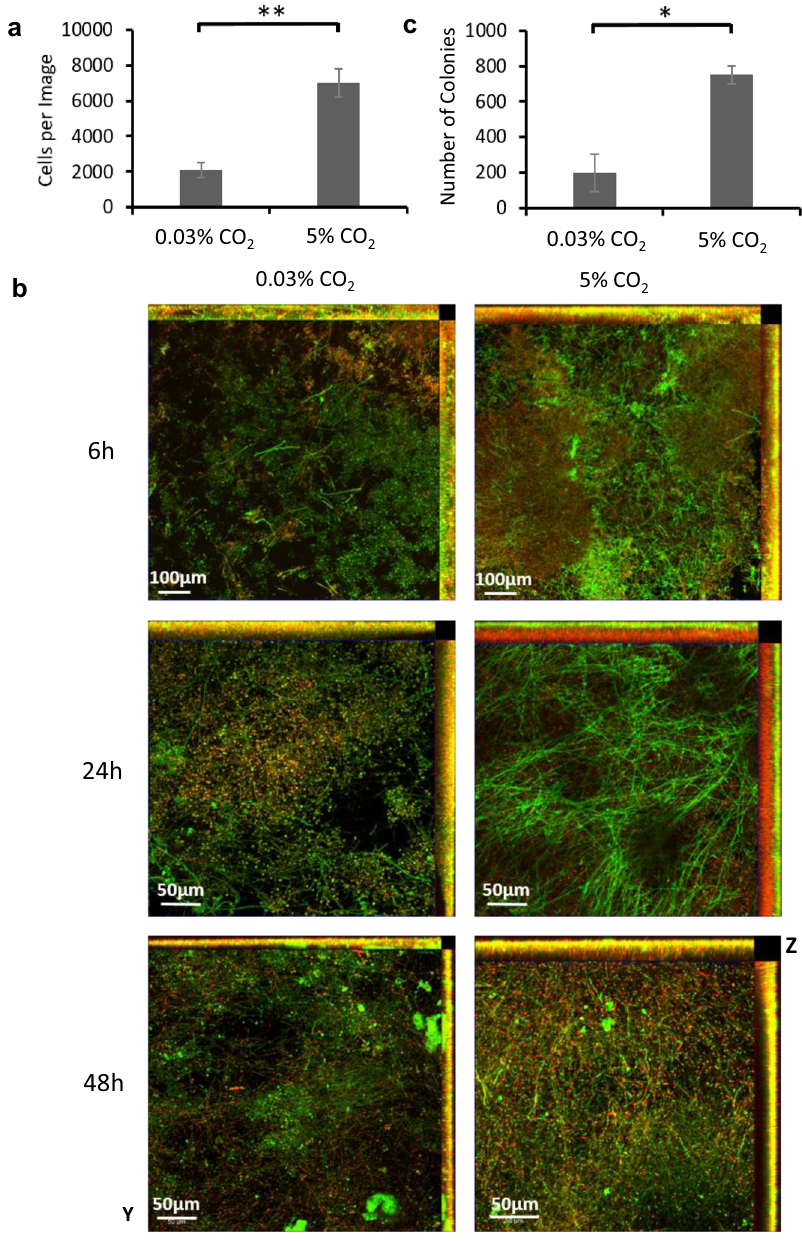
Fig. 2 The effects of CO 2 on C. albicans bio fi lm growth. a Attachment: C. albicans CAI-4 cells were seeded onto silicone-coated microscope slides under 0.03% or 5% CO 2 and images were taken at ×20 objective magni fi cation. Cells per image were counted and the mean was calculated across three biological replicates ( fi ve images per replicate). A paired two-tail t test was carried out: ** p < 0.01. Error bars denote standard deviation. b Maturation: Bio fi lms were seeded on silicone-coated microscope slide and grown for 6, 24 and 48 h. Bio fi lms were stained with ConA-FITC (green) and FUN-1 (red). Z -stack images were taken using ×20 (6 h) and ×40 (24 and 48 h) magni fi cations. Experiments were repeated in triplicate and representative maximum intensity images are presented as well as Z -stack pro fi les. c Dispersion: Spent media was collected from bio fi lms grown for 48 h in 0.03% or 5% CO 2 and diluted 1:10 before being plated to assess the number of colonies. Three biological replicates each containing technical triplicates were conducted, error bars denote standard deviation. A paired two-tail t test was carried out: * p < mutants (Fig. 4a). This is an important observation as it indicates altered bio fi lm formation in 0.03% and/or 5% CO 2 (Fig. 4a and that an increase in CO 2 concentration is suf fi cient to compensate Supplementary Table S2). Mutants lacking genes expressing for the loss of these TFs. The HAP complex in C. albicans is components of the HAP complex: hap2 Δ / Δ , hap3 Δ / Δ , hap5 Δ / Δ responsible for the regulation of iron homoeostasis 31 . Sef1 acts and hap43 Δ / Δ , exhibited signi fi cantly reduced bio fi lm growth after 48 h compared to wild type in 0.03% CO 2 . However, their downstream of this complex as an activator of iron uptake genes and the sef1 Δ / Δ mutant displayed signi fi cantly reduced bio fi lm bio fi lm growth was signi fi cantly higher in 5% CO 2 , reaching wild- growth in both 0.03% and 5% CO 2 after 48 h growth (Fig. 4a). The type levels in the cases of the hap3 Δ / Δ , hap5 Δ / Δ and hap43 Δ / Δ